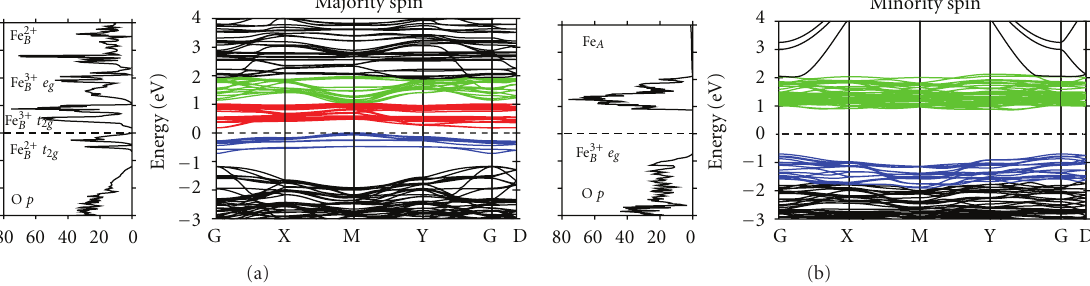
Figure 10: Total DOS and band structure of the P 2 /c phase of Fe 3 O 4 self-consistently obtained by the LSDA+ U with U = 5eV and J = 1 eV [155]. The Fermi level is denoted by the horizontal line and is taken as the zero of energy. A bandgap of 0.18 eV opens between M and Γ symmetry points. The energy bands predominantly originating from the Fe 3+ (green) colors, respectively, whereas the gray (blue) color corresponds to Fe 2+ between Fe 2+ e g and Fe A bands shown in dark gray (red) and light gray (green) colors, respectively. The corresponding contributions to the B total DOS are shown